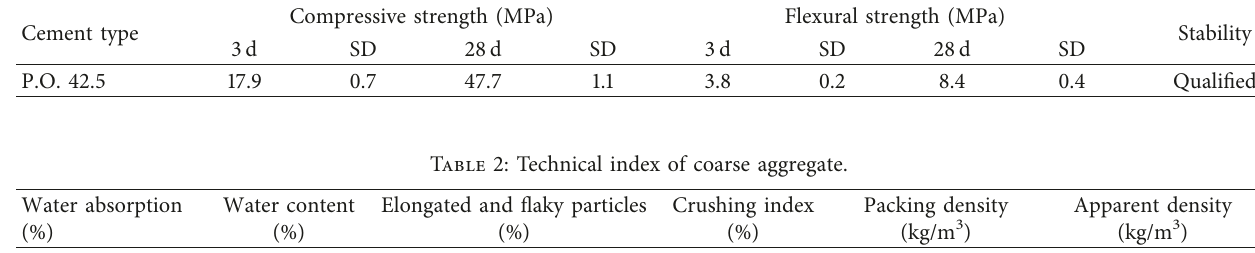
Table 1: Basic properties of cement used in this project.